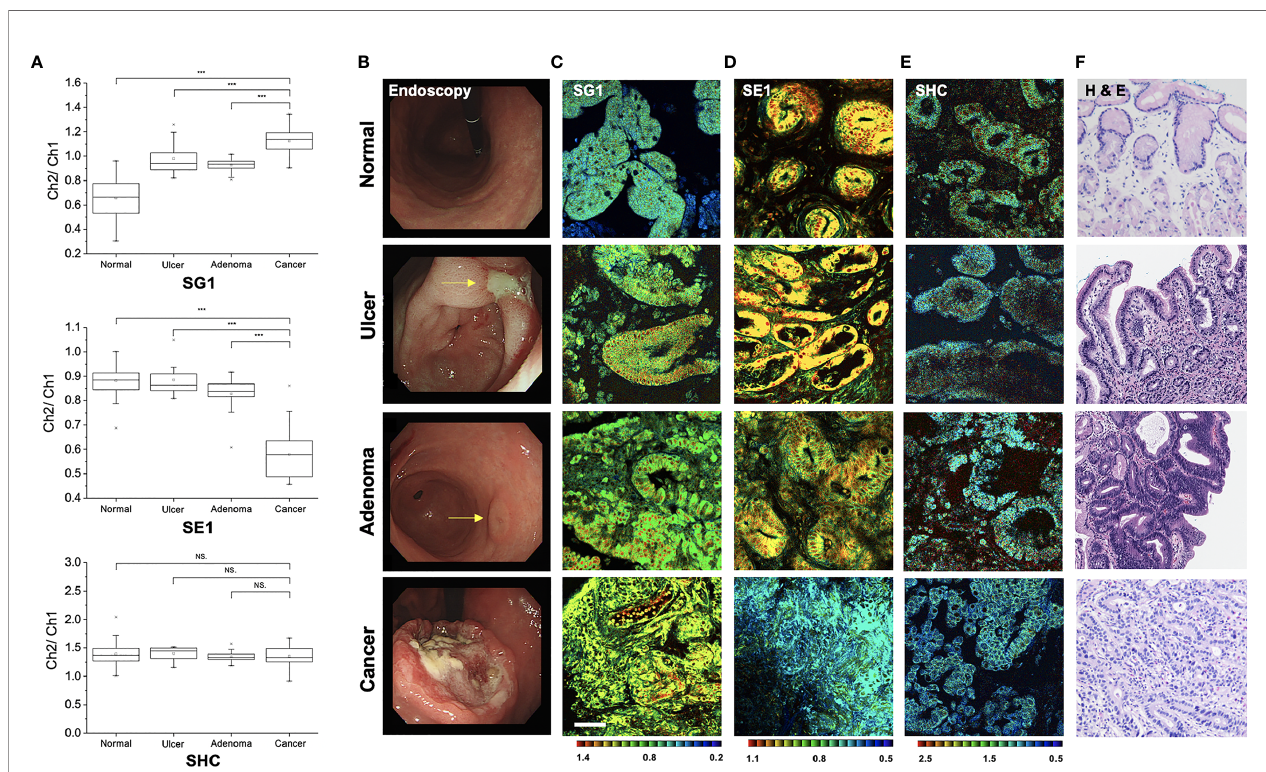
FIGURE 7 | Pseudo-colored ratiometric two-photon microscopy images (Ch2/Ch1) of normal, ulcer, adenoma, and cancer tissue. (A) Ratio value (Ch2/Ch1) box plots of normal, ulcer, adenoma, and cancer tissue (*** P < 0.001, NS, not signi fi cant). (B) Endoscopic image. (C) Two-photon microscopy images in SG1. (D) Two-photon microscopy images in SE1. (E) Two-photon microscopy images in SHC. (F) Histopathologic image with hematoxylin and eosin